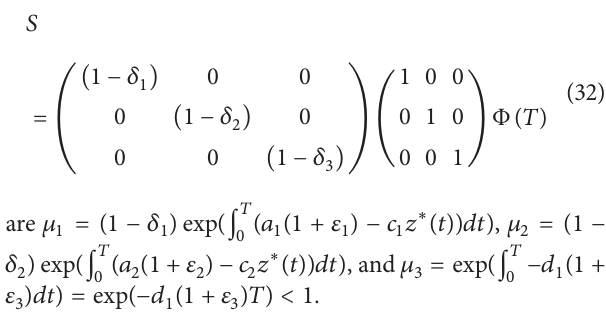
The resetting impulsive conditions of system (28)